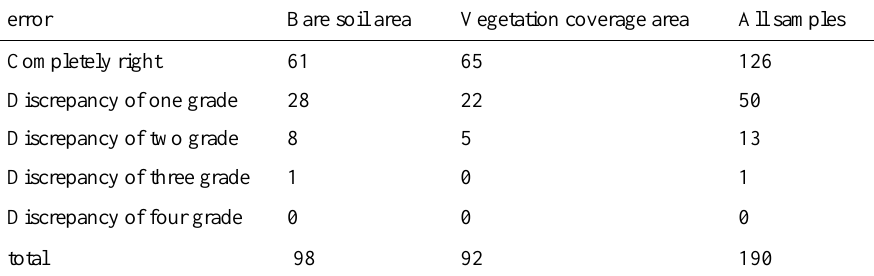
Table 4. The overall analysis of